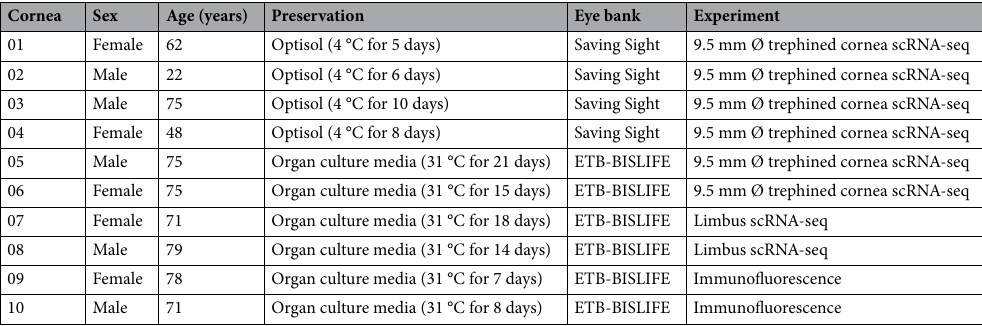
Table 1. Donor cornea